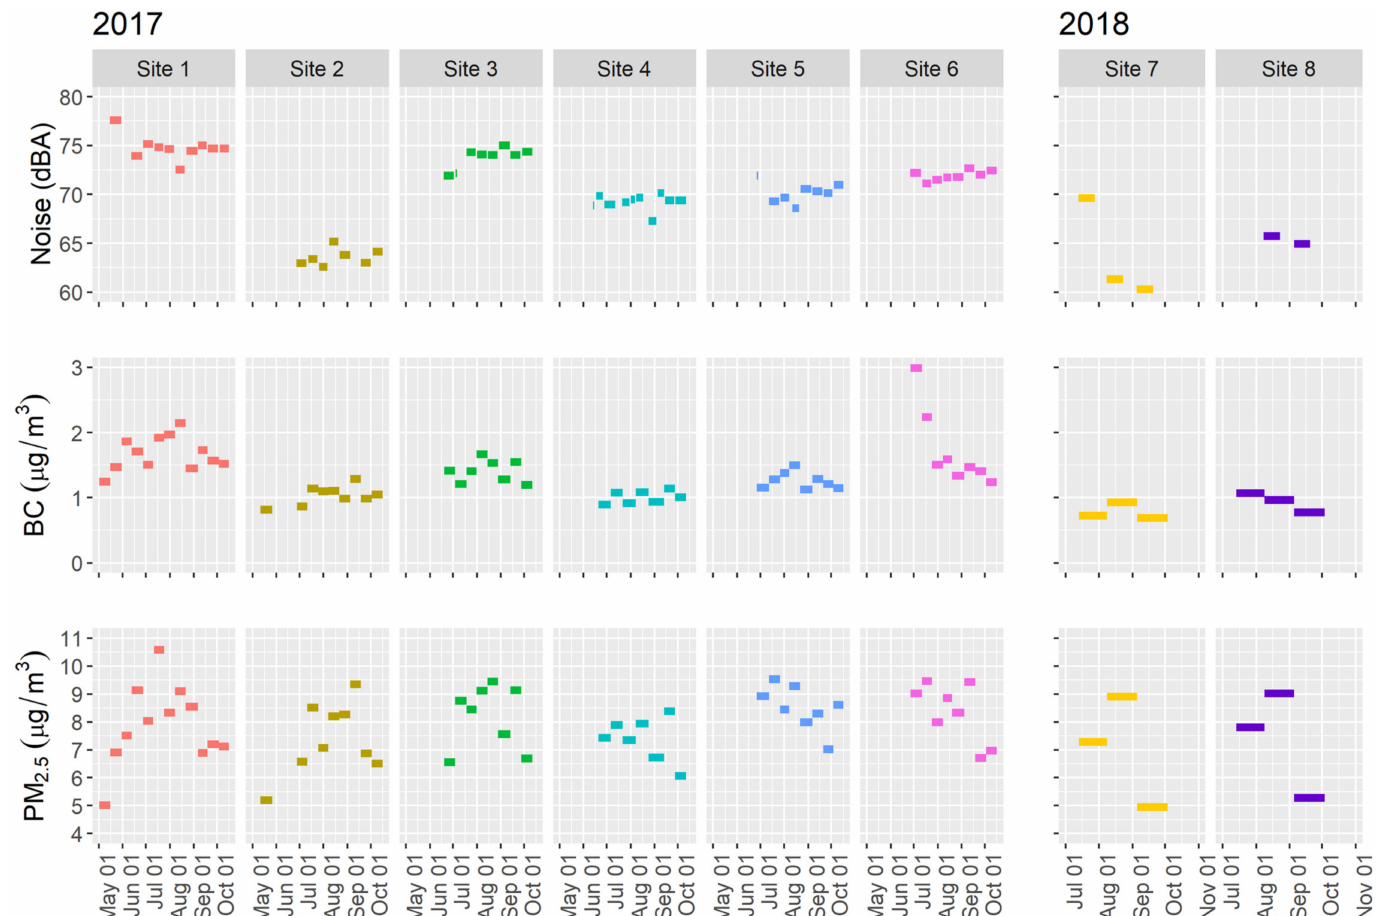
Figure 2. Time-integrated noise (top panel), black carbon (BC, middle panel), and particulate matter size 2.5 (PM 2.5 , bottom panel) measurements at the eight study sites. Measures are averaged over the period of times between site visits; approximately 2 weeks for Sites 1–6 and 4 weeks for Sites